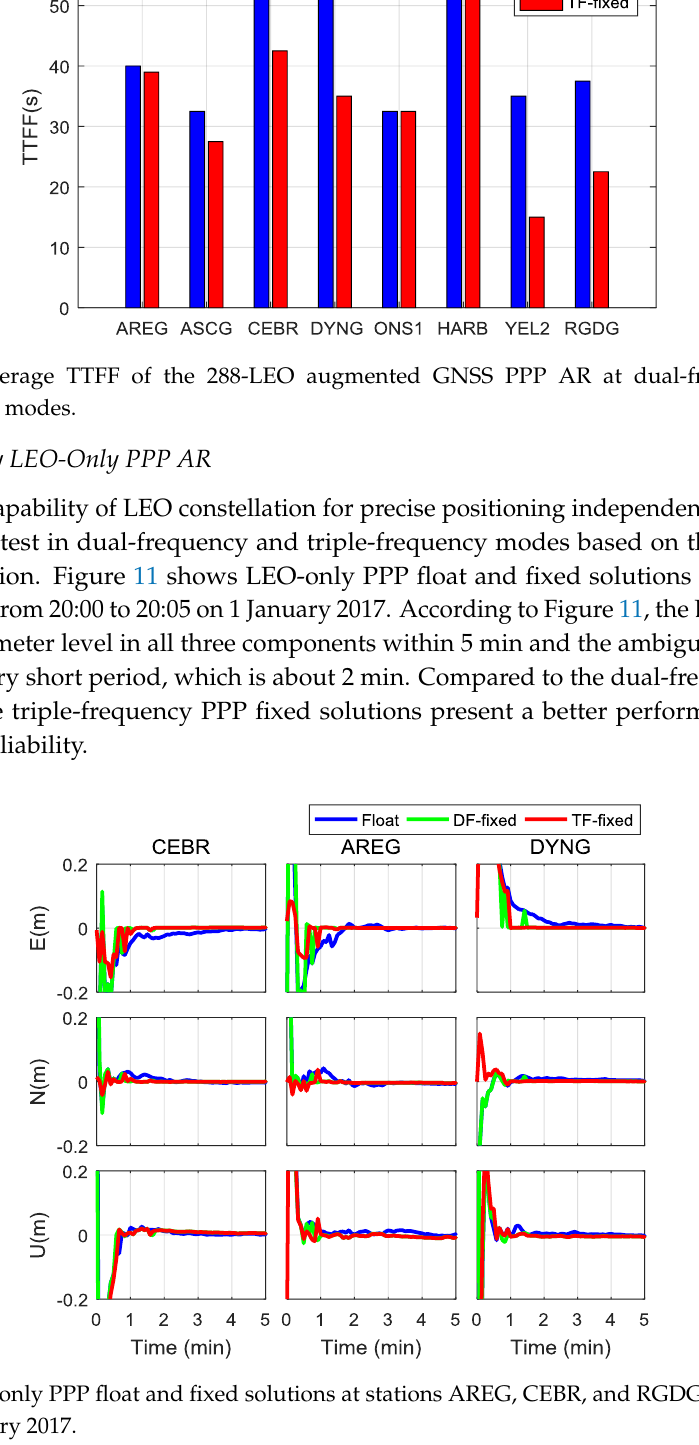
Figure 12. TTFF of LEO-only PPP AR for each user station. The positioning errors of 1-min static LEO-only float and fixed solutions are given in Figure 13. The positioning accuracy of LEO-only solutions can converge to 6 cm in all three components within 1 min. With the ambiguities fixed, the 1-min positioning accuracy can be significantly improved. The positioning error of triple-frequency PPP AR at 1 min is (1.69, 0.75, 4.16) cm in the east, north, and up components, respectively, with an improvement of 63.2%, 67.2%, and 20.7% compared to the PPP float solutions, and 50.2%, 56.8%, and 17.2% compared to the dual-frequency PPP fixed solutions. It also demonstrates the benefit of the third frequency for PPP ambiguity resolution.